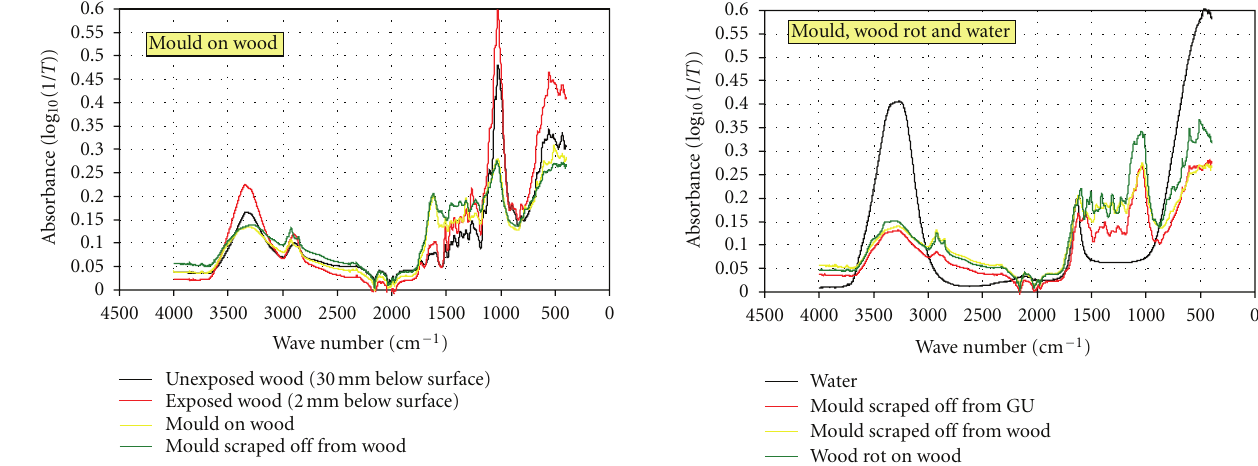
Figure 3: Absorbance (logarithmic) versus wave number between 4000–400 cm − 1 for mould fungi at various exposure levels on a wood sample.